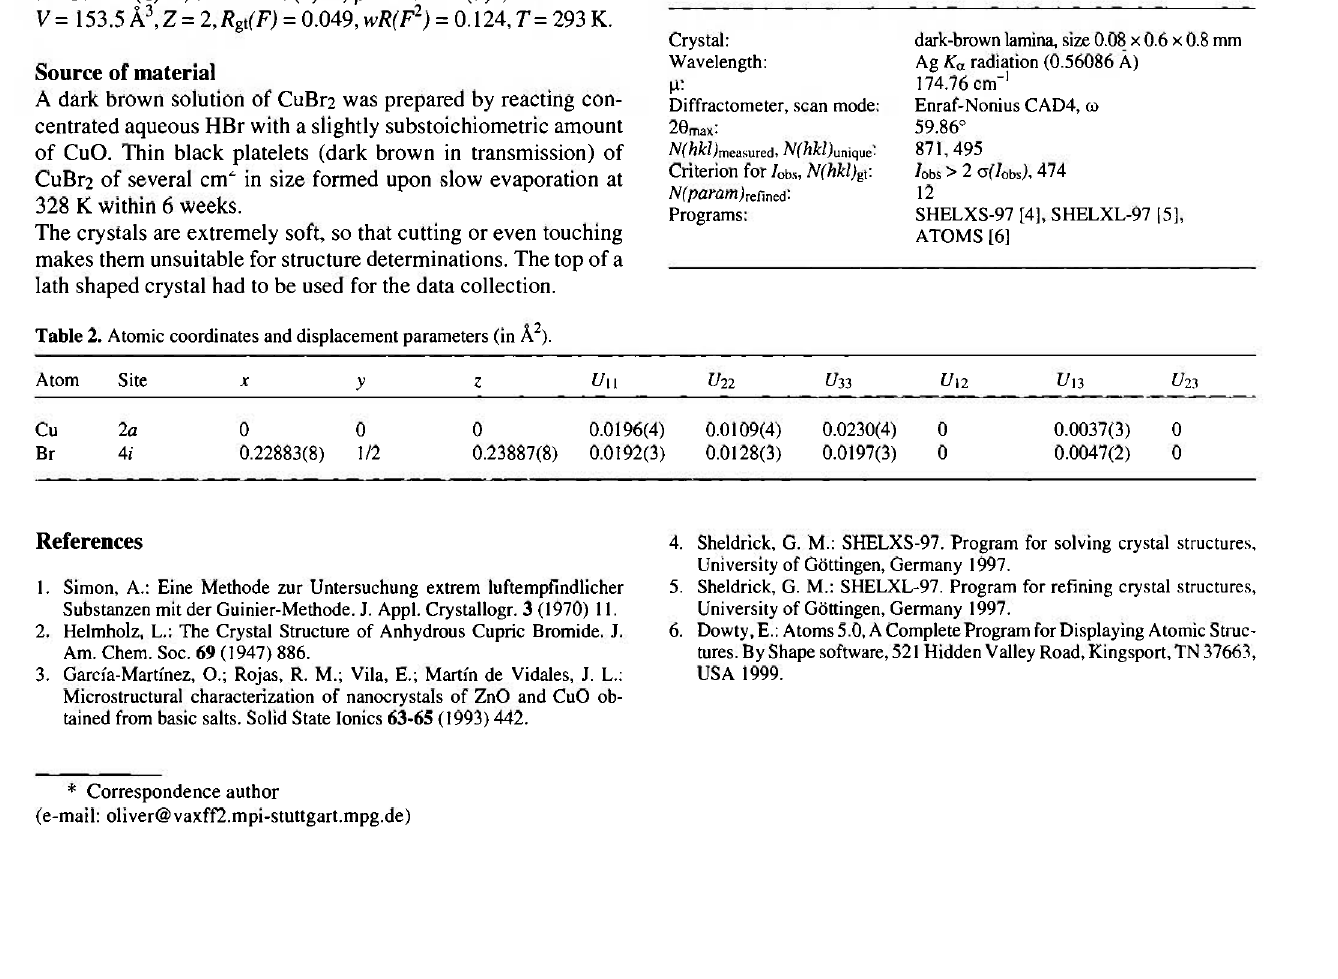
Table 1. Data collection and